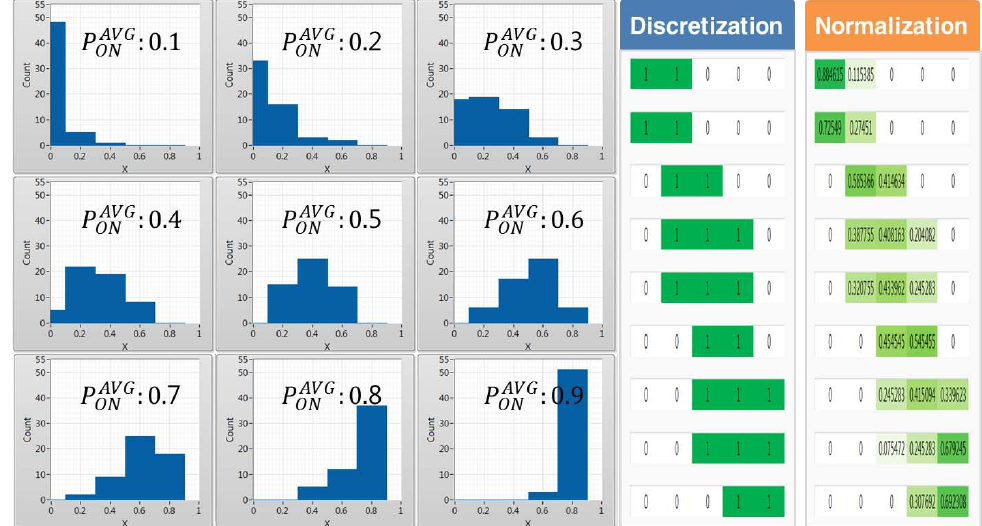
Figure 11. ( ∆ x = 20, L = 5) Histogram by average occupancy probability and pattern comparison by the data scaling method.